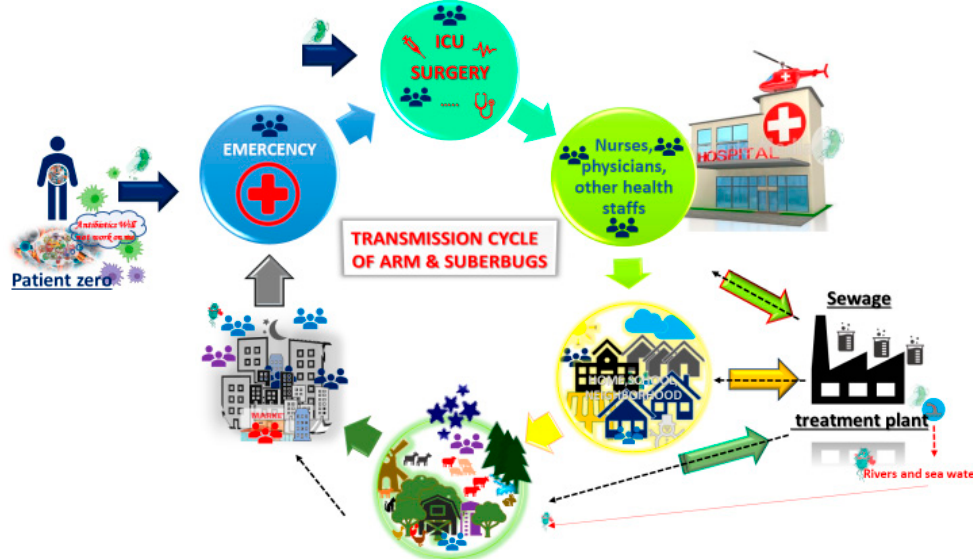
Figure 4. Transmission cycle of antimicrobial resistance (AMR) and/or superbugs. Patient zero (PZ)